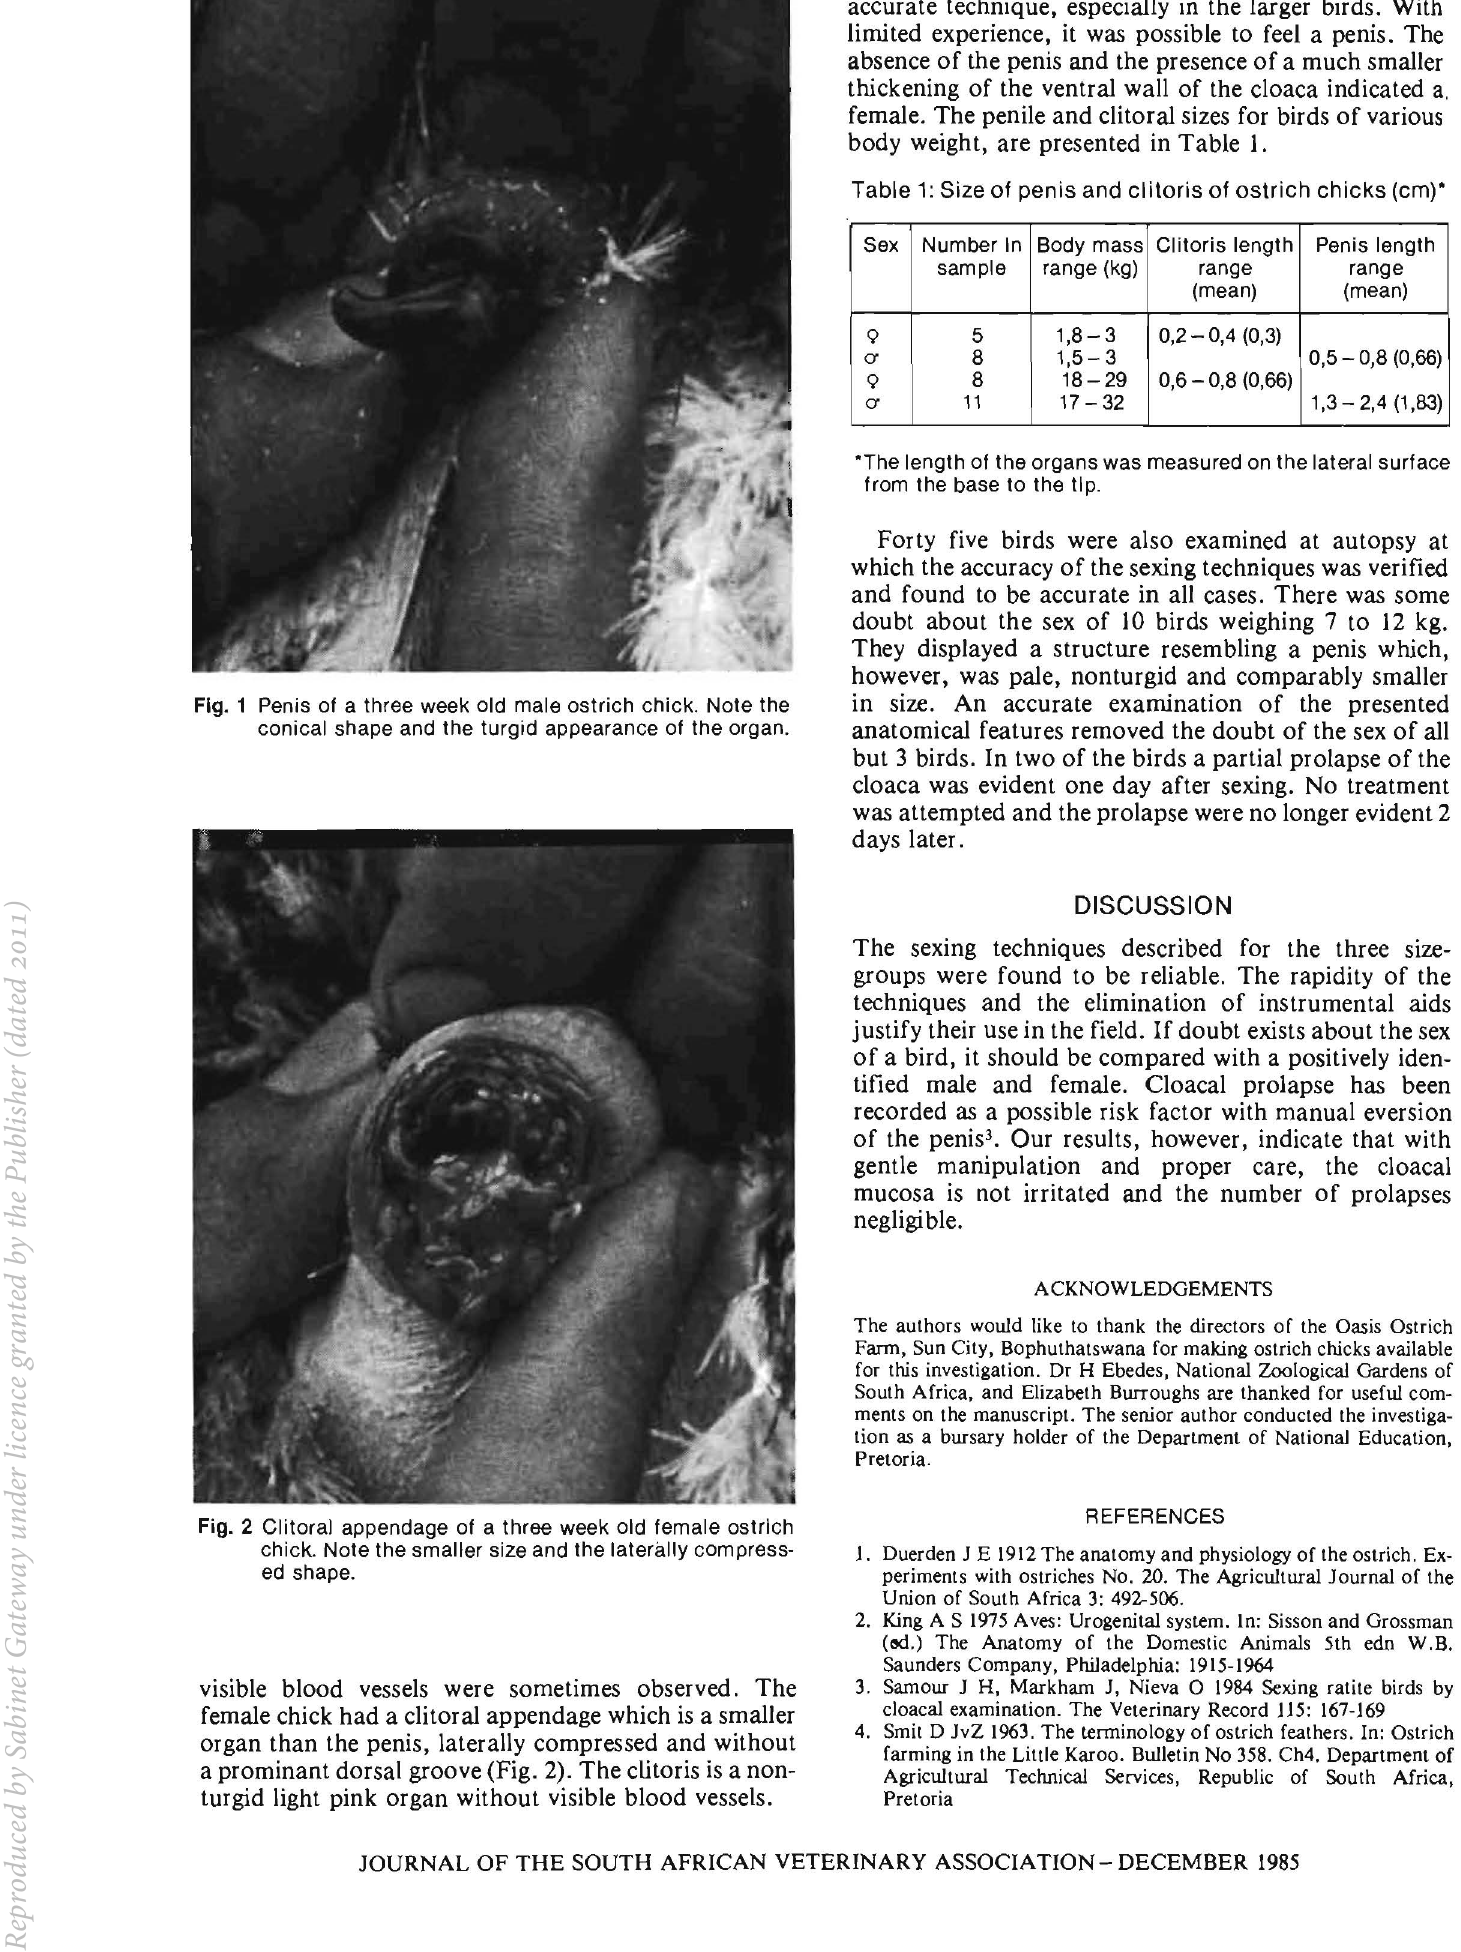
Table 1: Size of penis and clitoris of ostrich chicks (cm)" Sex Number In Body mass Clitoris length Penis length